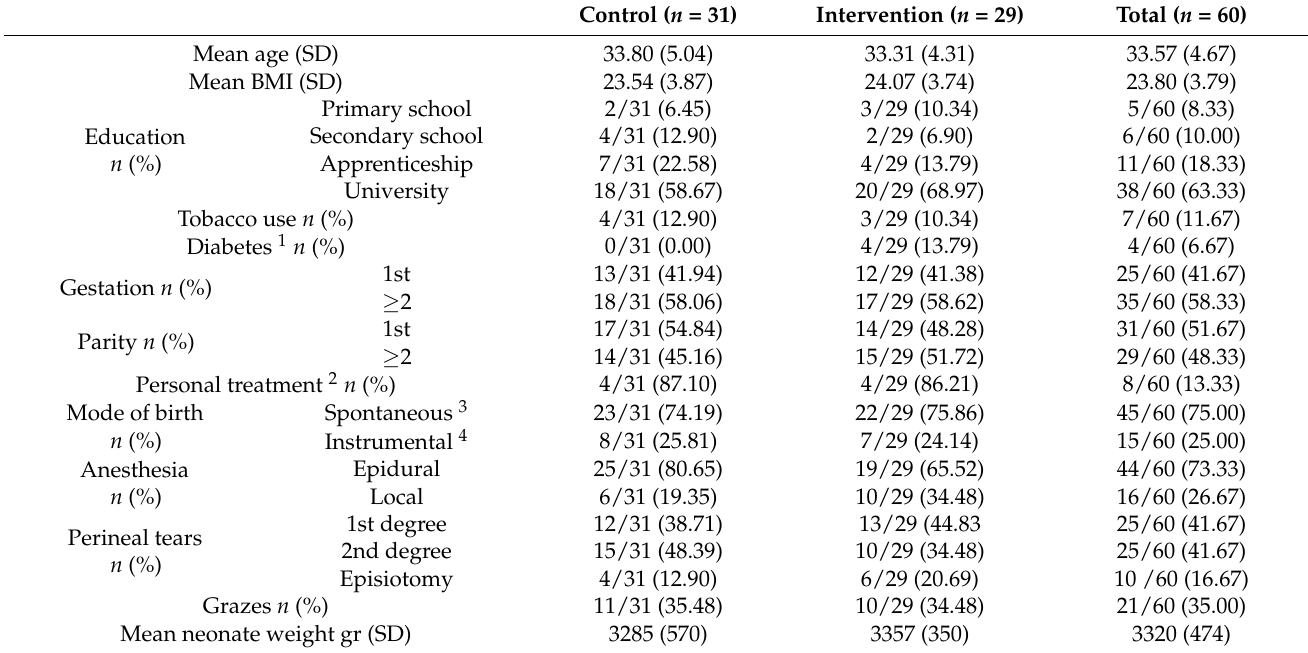
Table 1. Baseline sociodemographic and clinical characteristics.